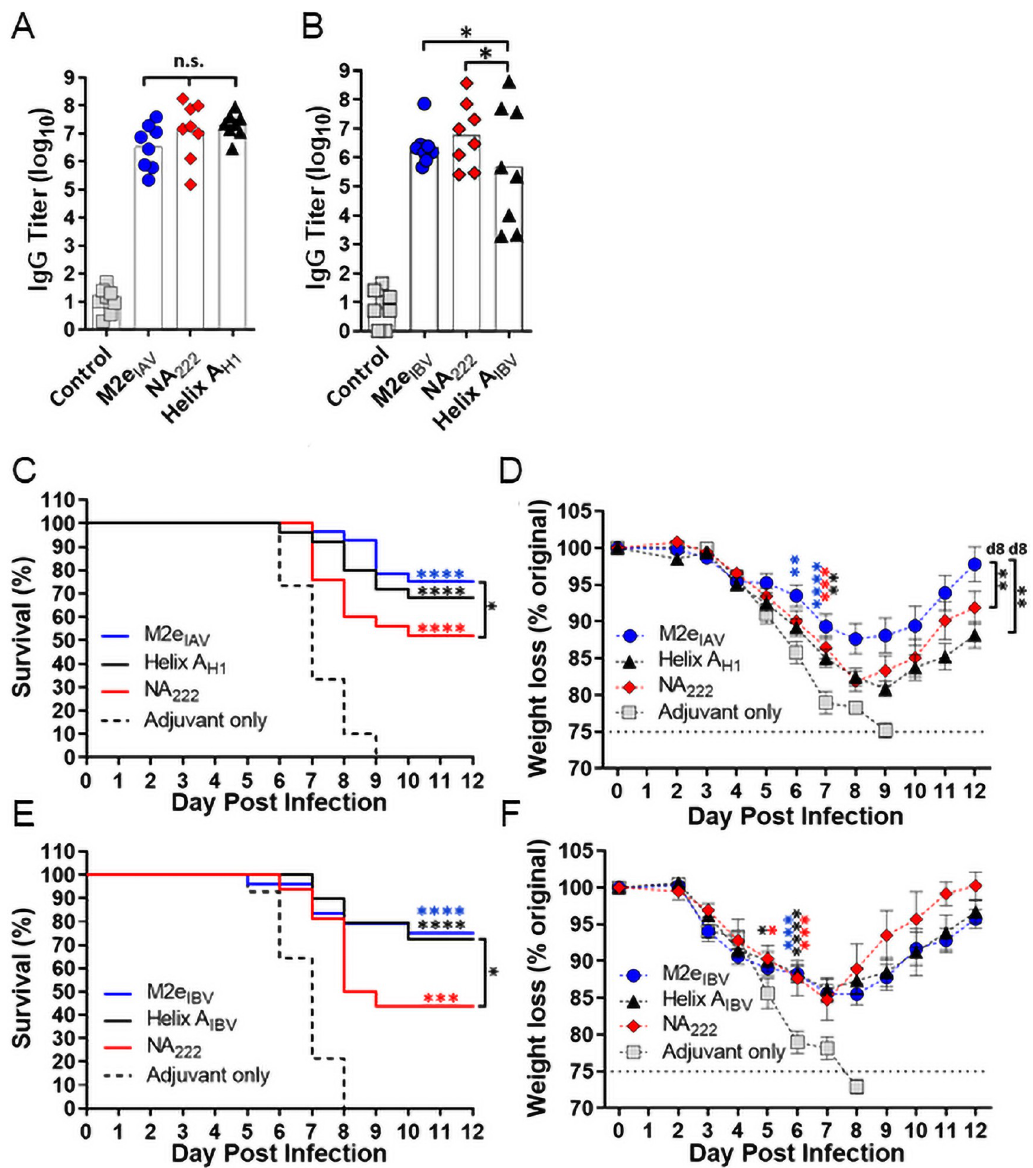
Fig 1. Peptides targeting conserved IAV and IBV epitopes stimulate robust antibody responses and confer protection against lethal challenge. CD-1 mice (n = 8) were immunized in a prime-boost regimen with the indicated ( A ) IAV or ( B ) IBV peptides plus GLA-SE (or GLA-SE only as a control) and d35 sera was assayed for titers by ELISA. A one-way analysis of variance (ANOVA) followed by Tukey’s multiple comparisons test was used for statistical analysis ( � P < 0.05, n.s. not significant). On d42, mice were challenged with ( C , D ) A/California/07/2009 or ( E , F ) B/Florida/04/2006 and then monitored for survival and weight loss plotted as mean ± S.E.M. Monovalent challenge data was compiled from three experiments (n = 5-8/experiment). Survival curves were compared by log-rank Mantel-Cox test. Data from each weight loss time point were compared by one-way ANOVA followed by Dunnett’s multiple comparisons test. Color coded asterisks without brackets denote significance between control and indicated test group. Brackets indicate comparison between test groups. For weight loss, significance over the control is shown until maximum difference and comparison between test groups was maximum on the designated day ( � P < 0.05, �� P < 0.01, ��� P < 0.001, ���� P <